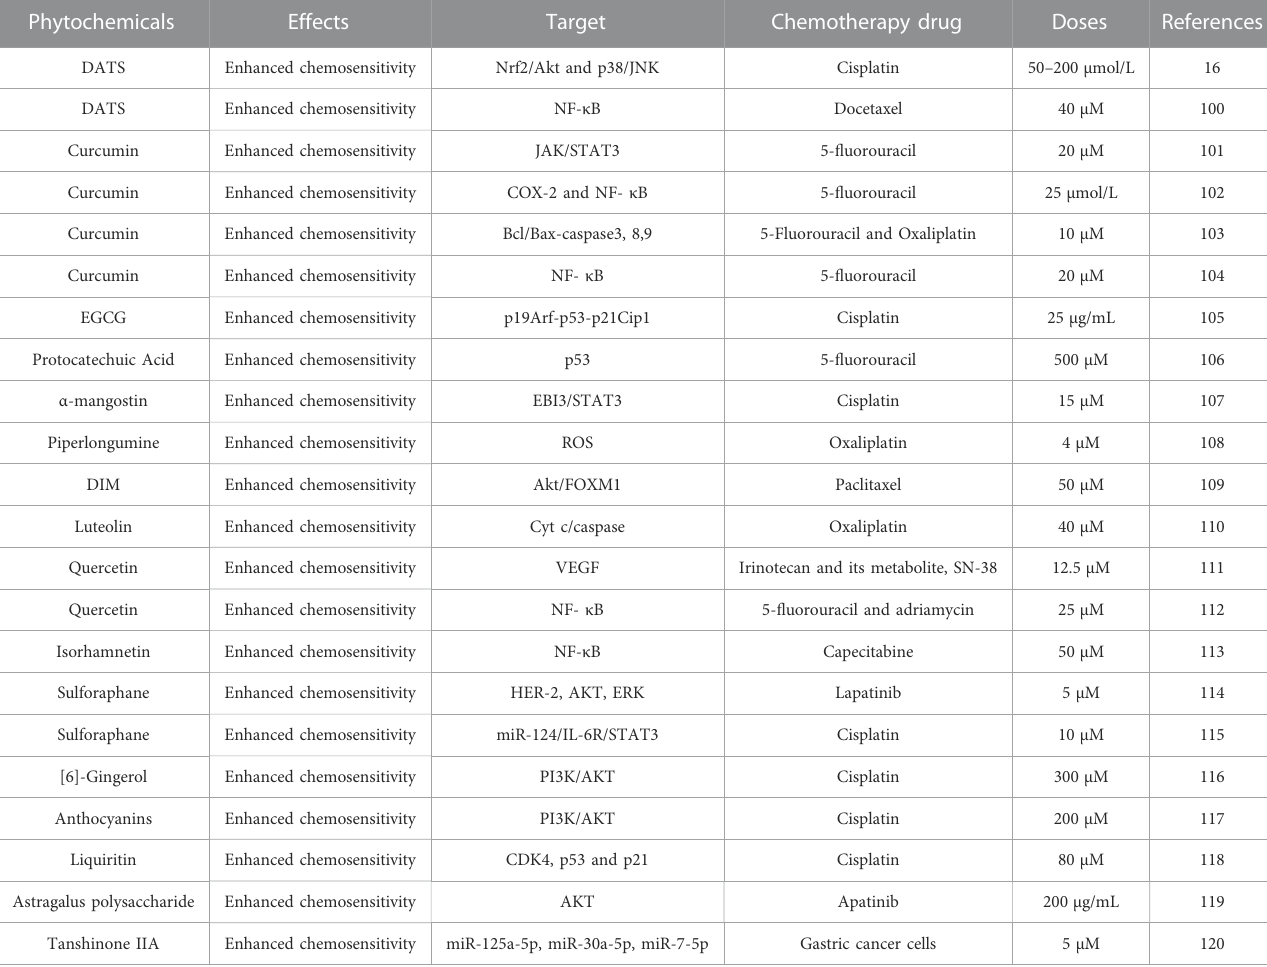
TABLE 4 Overview of the effect of phytochemicals on